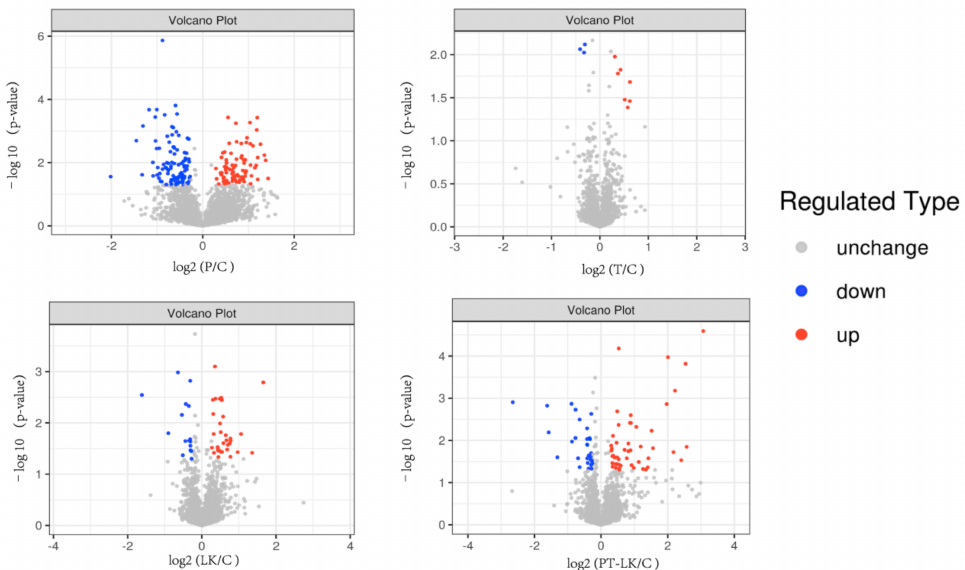
Figure 5. Volcano plot of changes in the levels of identified B. subtilis spore proteins analyzed using TMT quantitative proteomics after different treatments.